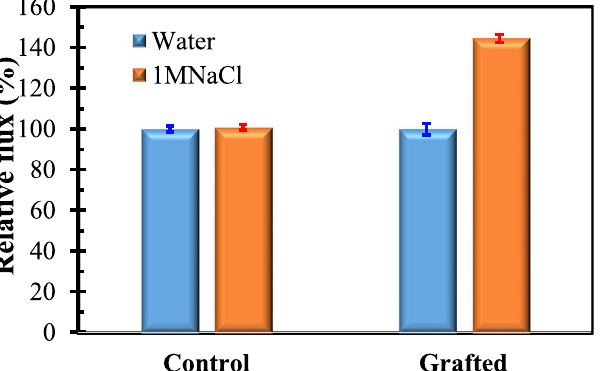
Figure 11. Effect of the ionic strength on the fluxes of the control and grafted